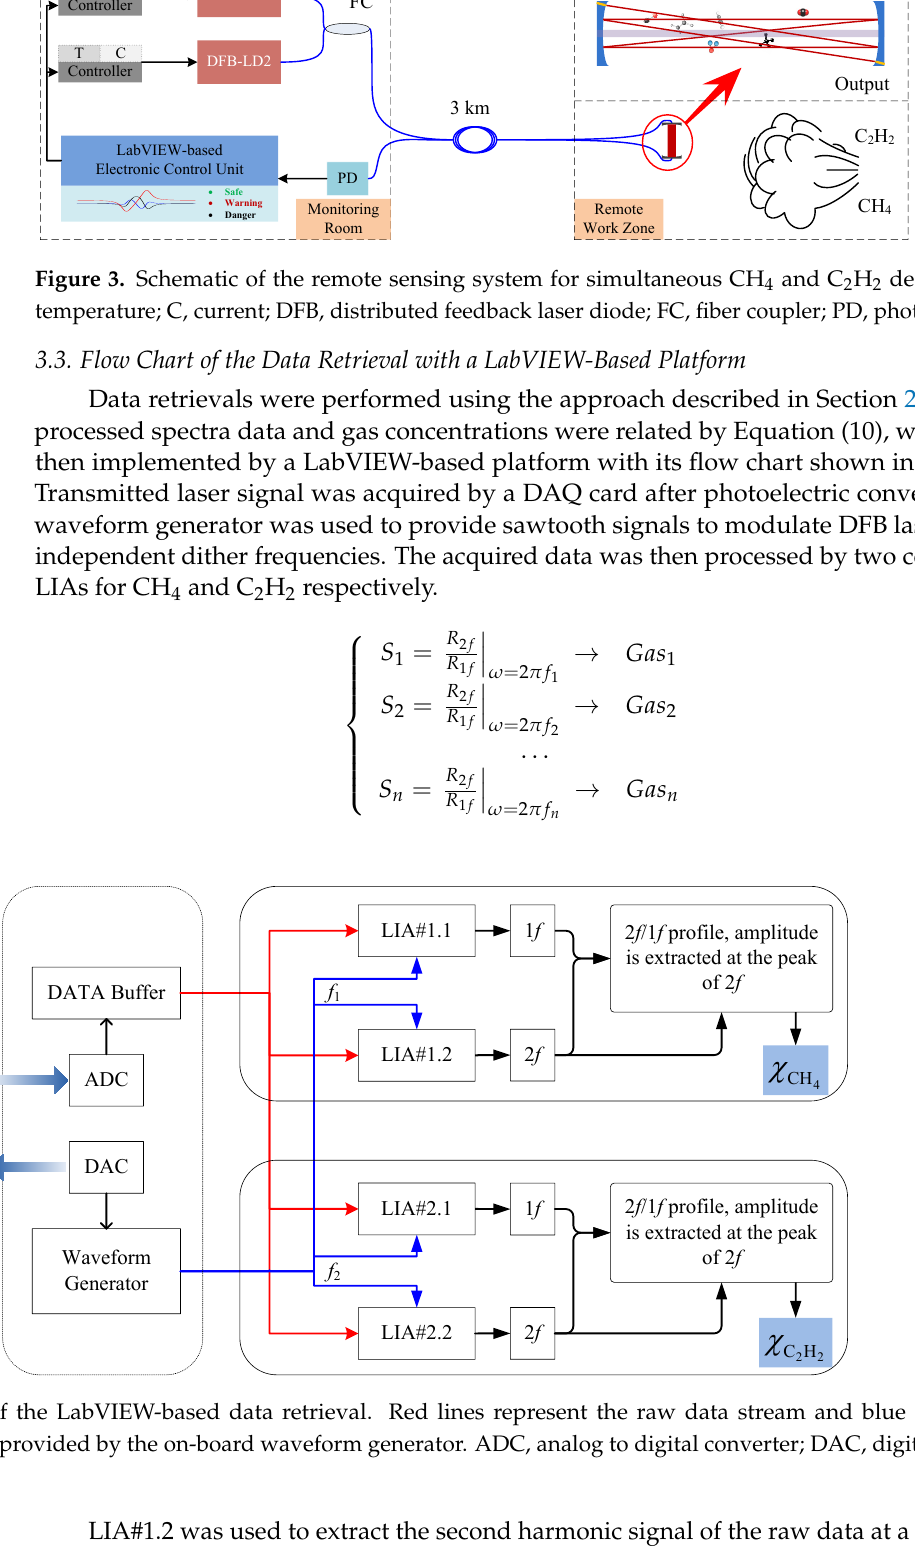
Figure 3. Schematic of the remote sensing system for simultaneous CH 4 and C 2 H 2 detection. T, temperature; C, current; DFB, distributed feedback laser diode; FC, fiber coupler; PD, photodetec- tor.